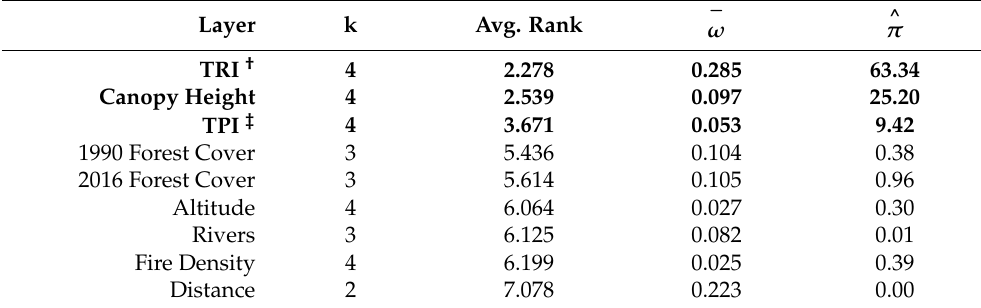
Table 1. Results from bootstrap selection of optimized linear-mixed effects models on single surfaces. Rows shown in bold indicate models that performed better than Euclidean distance alone and